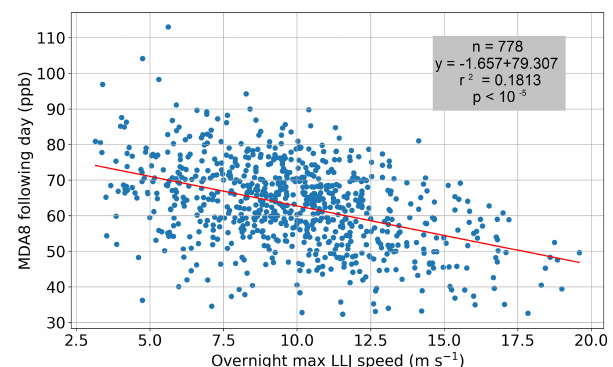
Figure 11. Correlation between nocturnal low-level jet speed and the following day’s MDA8 in Visalia, CA, for calendar days 152– 273 from 2010 to